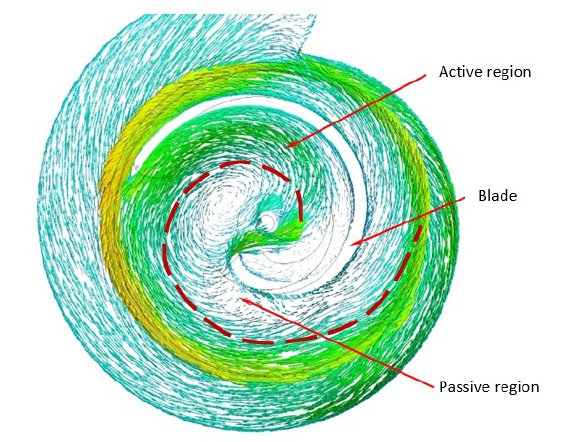
Figure 8: The velocity distribution and the division of fluid sections in the impeller